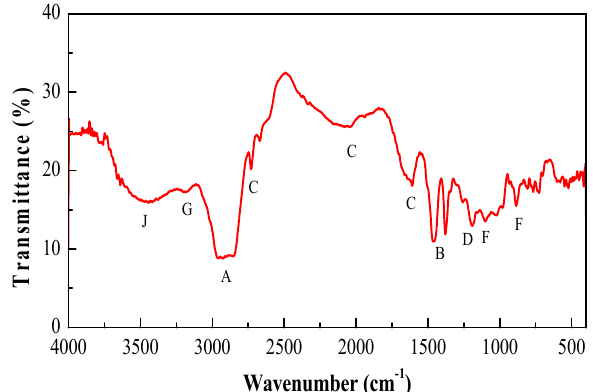
Figure 5. FTIR spectroscopy for an emulsion formed in extraction with the addition of a strong alkali. A, stretching vibration of C-H; B, bending vibration of C-H; C, P-O-H bond vibrations of hydrogen bond association; D, coupled vibration of P=O bond; F, coupled vibration of P-O-C bond; J, O-H vibration.